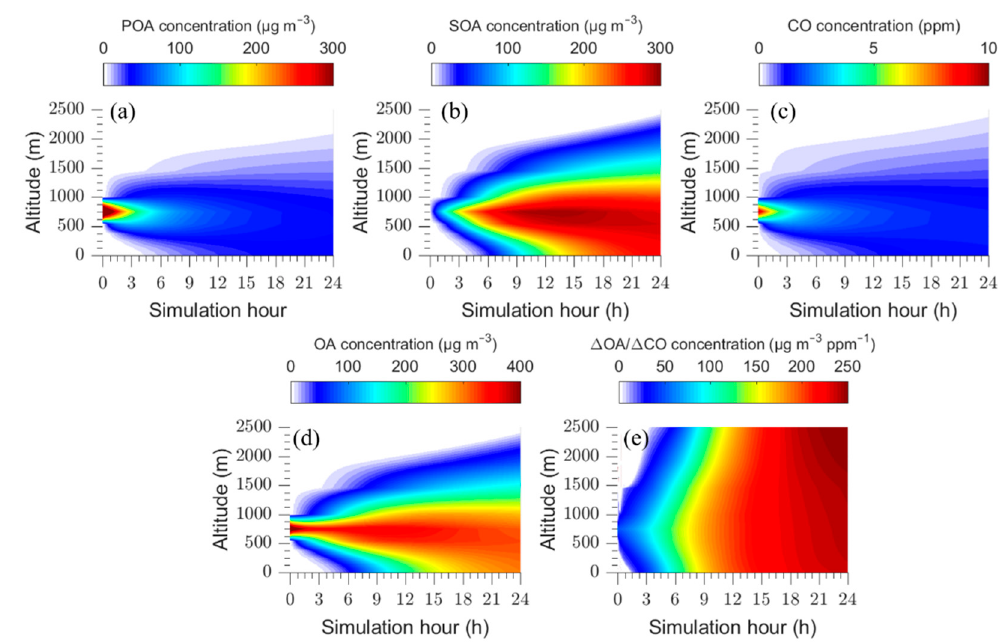
Figure 1. Time dependent vertical profiles of: ( a ) POA; ( b ) SOA; ( c ) total OA; ( d ) CO concentrations, and ( e ) ∆ OA/ ∆ CO for the base case.